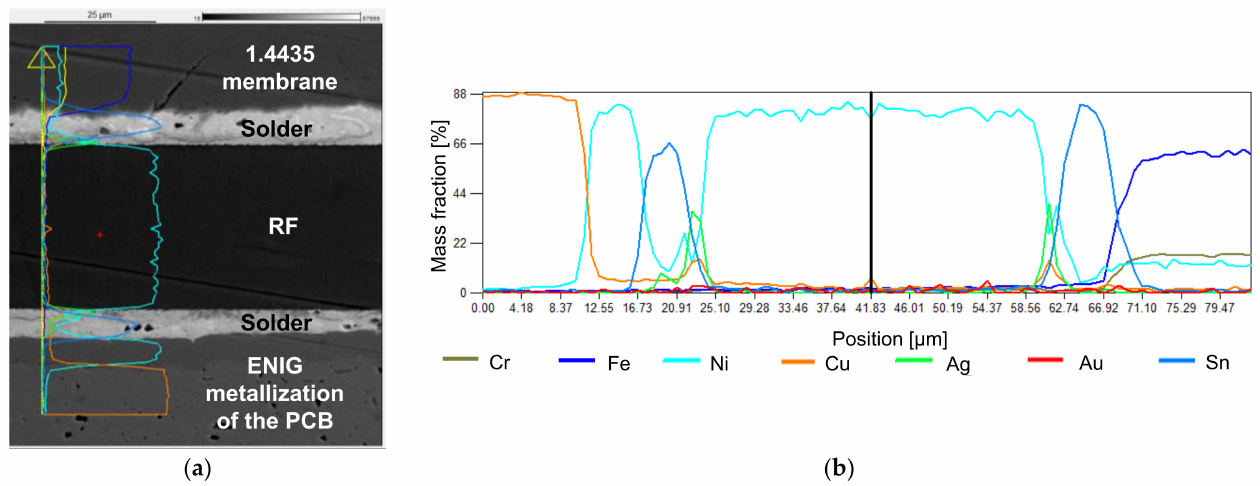
Figure 17. SEM-EDX image with elemental analysis of reactive joining: ( a ) image with indication of the position of the EDX line scan; ( b ) EDX elemental analysis of the bond (line